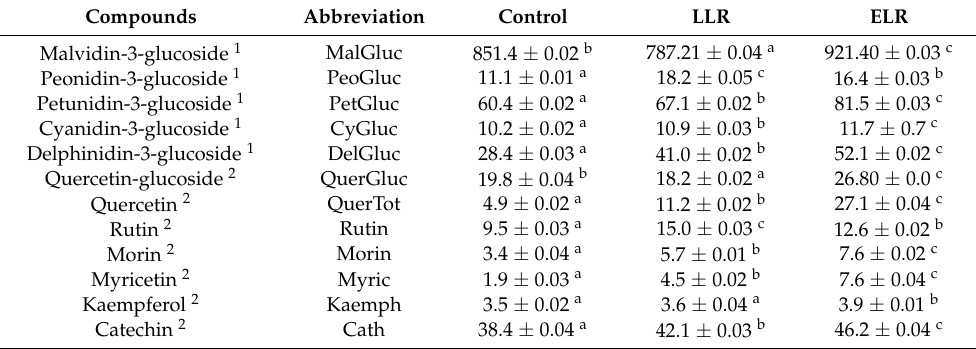
Table 6. Effects of leaf removal on the concentrations (mg L − 1 ) of different phenolic compounds (flavanols and anthocyanins) in wine (after 6 months of aging) determined by HPLC. LLR, late leaf removal; ELR, early leaf removal. The results from representative year (2012) are shown. Data are means of three replicates ± SD. Different letters in a row denote significant difference between parameter means after Tukey’s test following one-way ANOVA ( p <